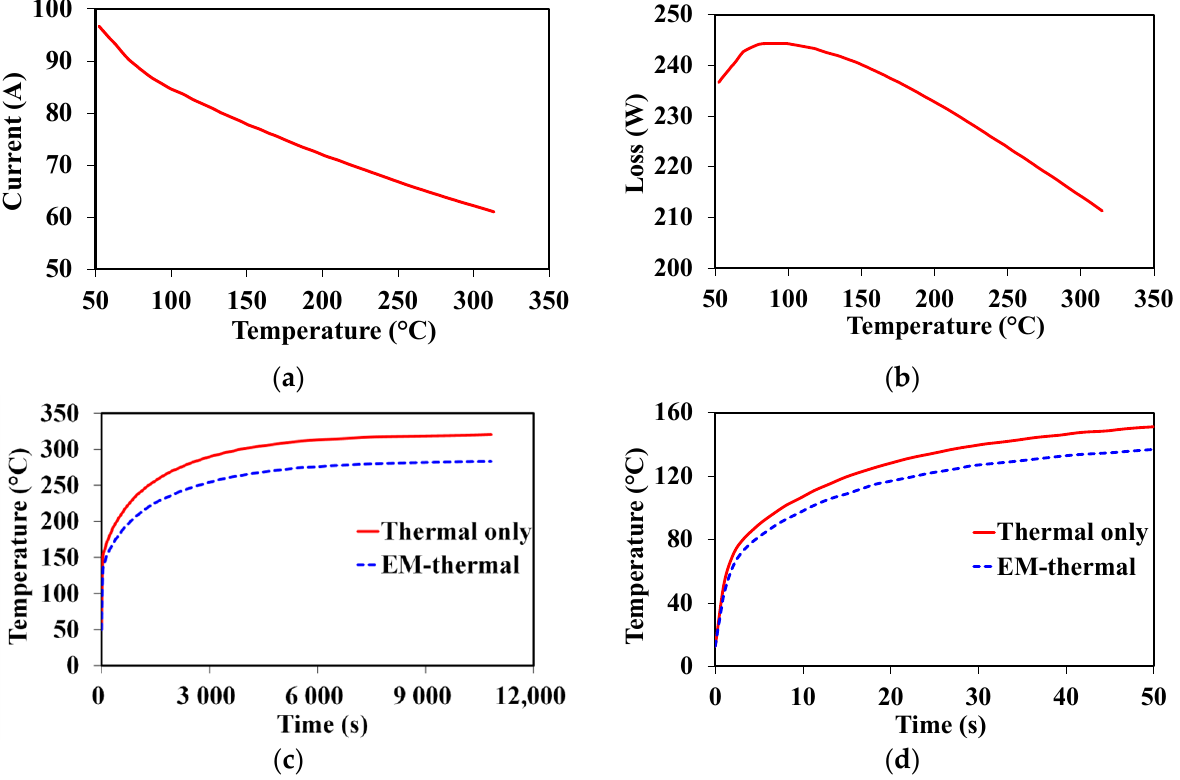
Figure 16. Thermal behavior of the fault-tolerant PM motor under inter-turn SC fault. ( a ) The variation in SC current with temperature. ( b ) The variation in the loss of SC turns with temperature. ( c ) Transient temperature rise in the SC turns. ( d ) Transient temperature rise in the SC turns in the first 50 s.